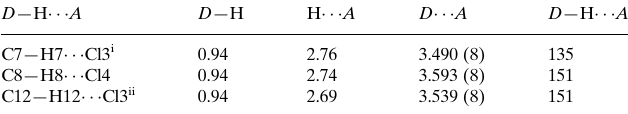
Hydrogen-bond geometry (A˚ , (cid:4)